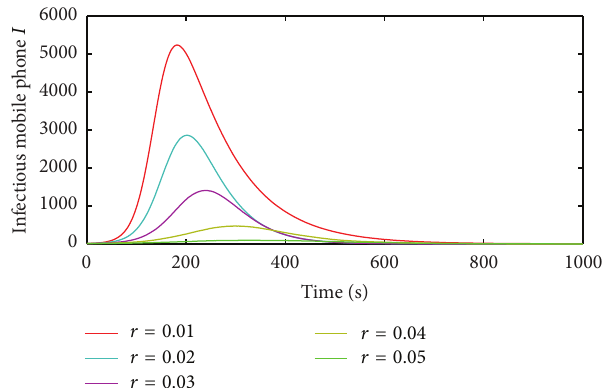
Figure 11: Effect of the immune rate 𝛾 in the M-SIR